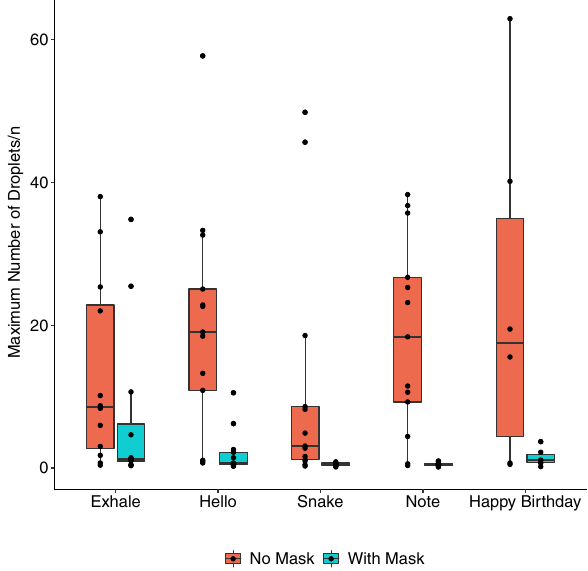
Figure 4. Boxplot demonstrating maximum droplet number (MDN) across a number of vocal tasks. Sub-table presents median and interquartile range (IQR) of each task, with Wilcoxon signed-rank tests to compare each vocal task with and without a face mask. Figures produced in R software 4.0.4 34 using the ggplot2 package 35 .